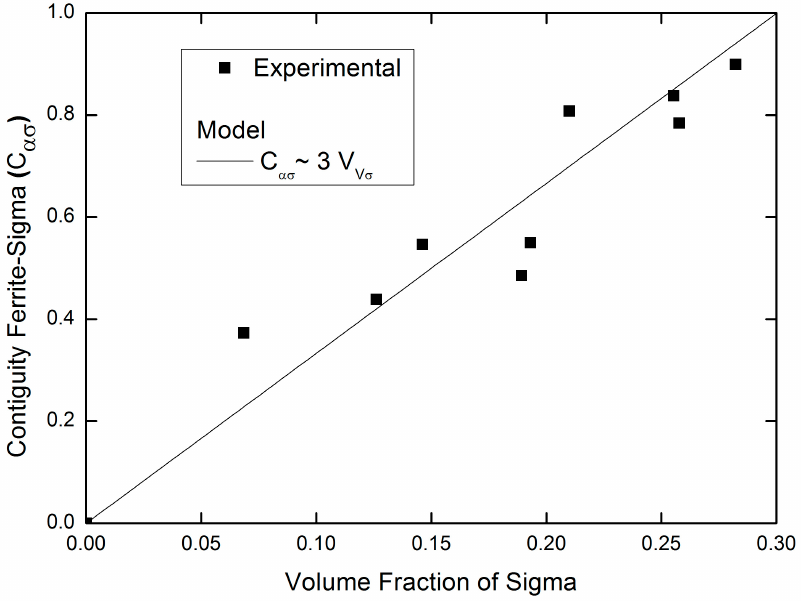
Figure 4. Contiguity ratio between the ferrite/sigma phases as a function of the volume fraction of sigma phase. In the case of random nucleation C ασ ≅ 3 V V σ , the straight line represented by this equation is also presented. C ασ : ferrite/sigma continuity and V V σ : volume fraction of sigma.